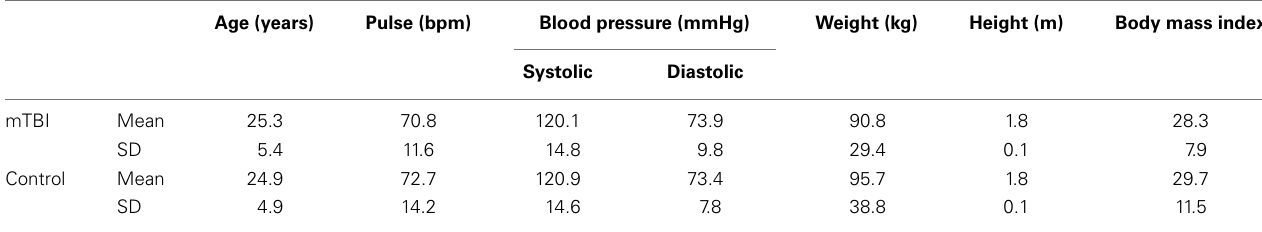
Table 1 | Comparison of physical parameters between